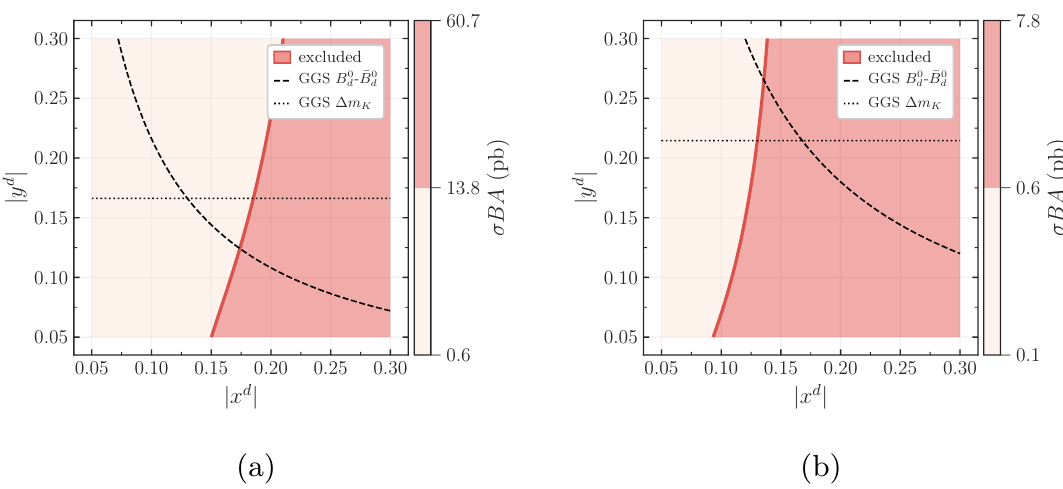
Figure 4 . Theoretical predictions of (cid:27)BA for the D d diquark (a) M 1 TeV, for di(cid:11)erent values of the light-quark coupling The observed 95% CL upper limit on (cid:27)BA [43] is indicated by the red solid line. The black dashed line and black dotted line denote the GGS constraints on